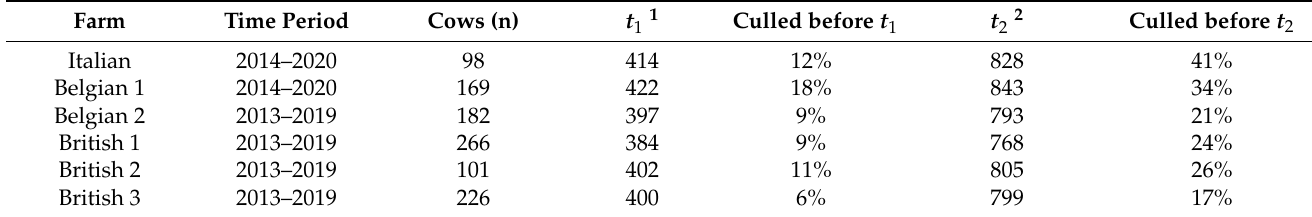
Table 1. Overview of the available datasets.